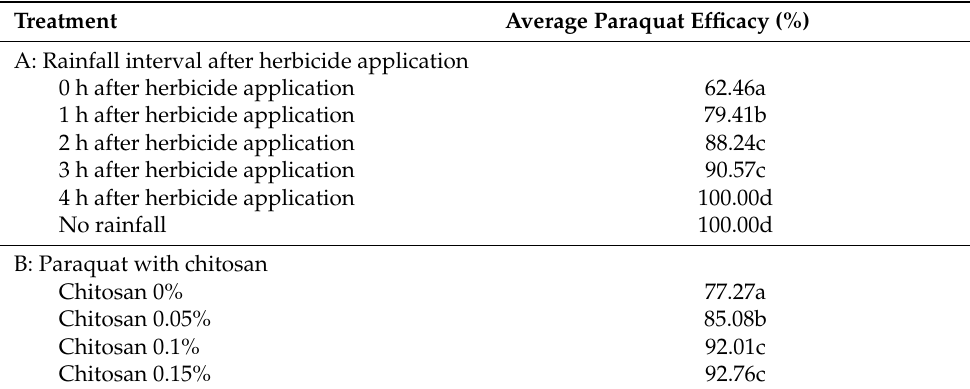
Table 3. Effect of simulated rainfall on herbicidal efficacy of a mixture of paraquat and chitosan against Borreria alata at different time intervals after mixture application.